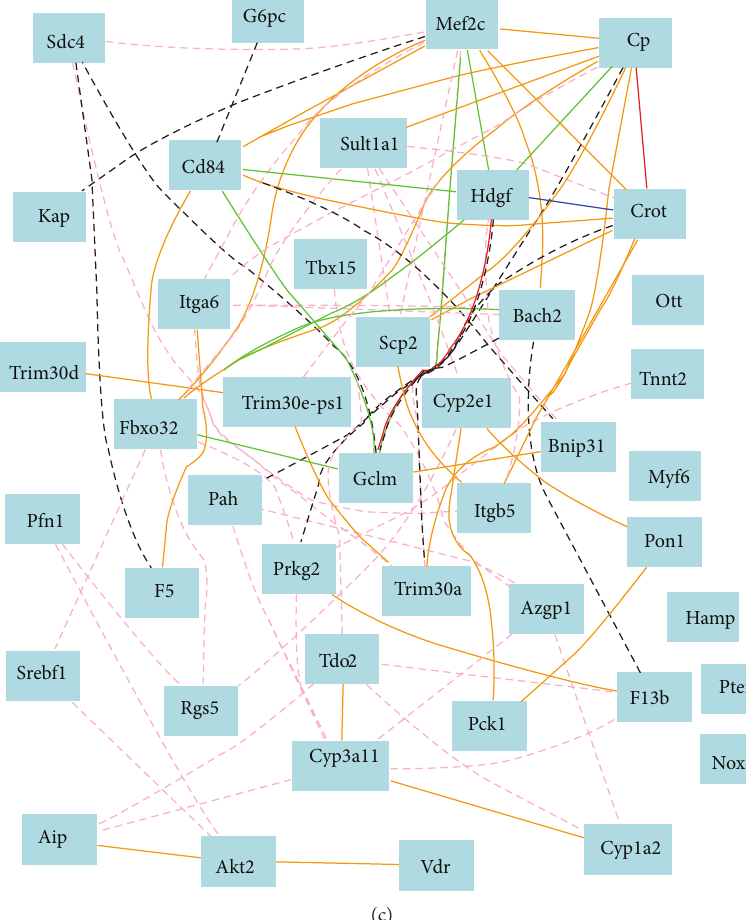
Figure 4: Gene network among bone relevant genes, which are upregulated in female while downregulated in female, constructed using expression profiles from spleen of female BXD mouse strains. (a) The 11 nodes in the graph below show the selected traits. All nodes are displayed. The 11 edges between the nodes, filtered from the 55 total edges and drawn as curves, show Pearson correlation coefficients greater than 0.35 or less than − 0.35. The graph’s canvas is 40.0 by 40.0 cm and the node labels are drawn with a 14.0 point font and the edge labels are drawn with a 10.0 point font. (b) The 31 nodes in the graph below show the selected traits. All nodes are displayed. The 49 edges between the nodes, filtered from the 465 total edges and drawn as curves, show Pearson correlation coefficients greater than 0.4 or less than − 0.4. The graph’s canvas is 40.0 by 40.0 cm and the node labels are drawn with a 14.0 point font and the edge labels are drawn with a 14.0 point font. (c) The 43 nodes in the graph below show the selected traits. All nodes are displayed. The 88 edges between the nodes, filtered from the 903 total edges and drawn as curves, show Pearson correlation coefficients greater than 0.4 or less than − 0.4. The graph’s canvas is 40.0 by 40.0 cm and the node labels are drawn with a 14.0 point font and the edge labels are drawn with a 14.0 point